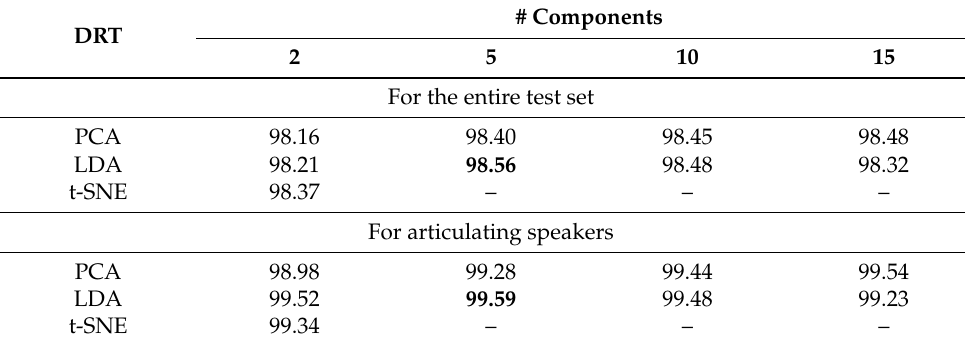
Table 11. The results of gesture recognition rate on the test set of the AUTSL dataset when optimizing the dimensionality reduction components for lip